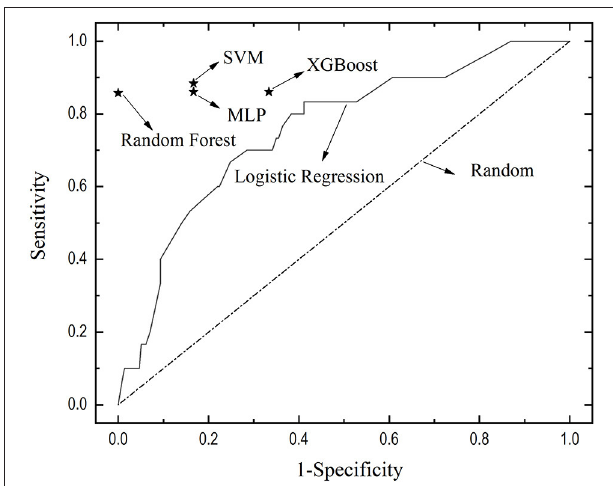
FIGURE 2 | The receiver of the curve of multivariate logistic regression and performance of four machine learning models. The true positive rate-false positive rate of different machine learning models was depicted, locating to the left of and above the ROC curve of logistic regression, indicating the better performance of machine learning models than logistic regression. XGBoosting, eXtreme Gradient Boosting; SVM, support vector machine; MLP, multilayer